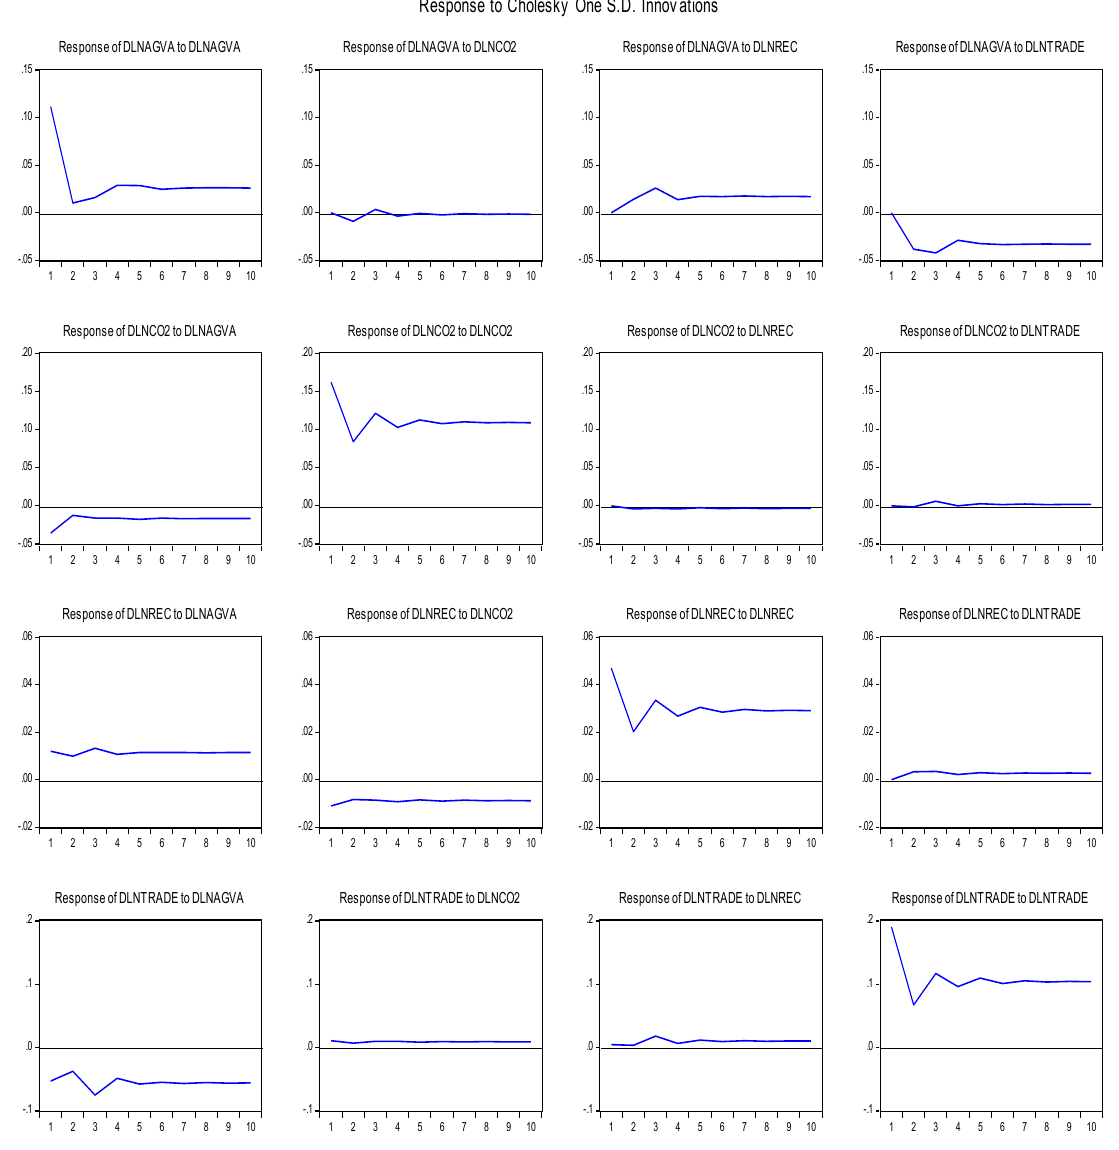
Figure A1. Policy responses in light of sustainable development agenda (Agenda